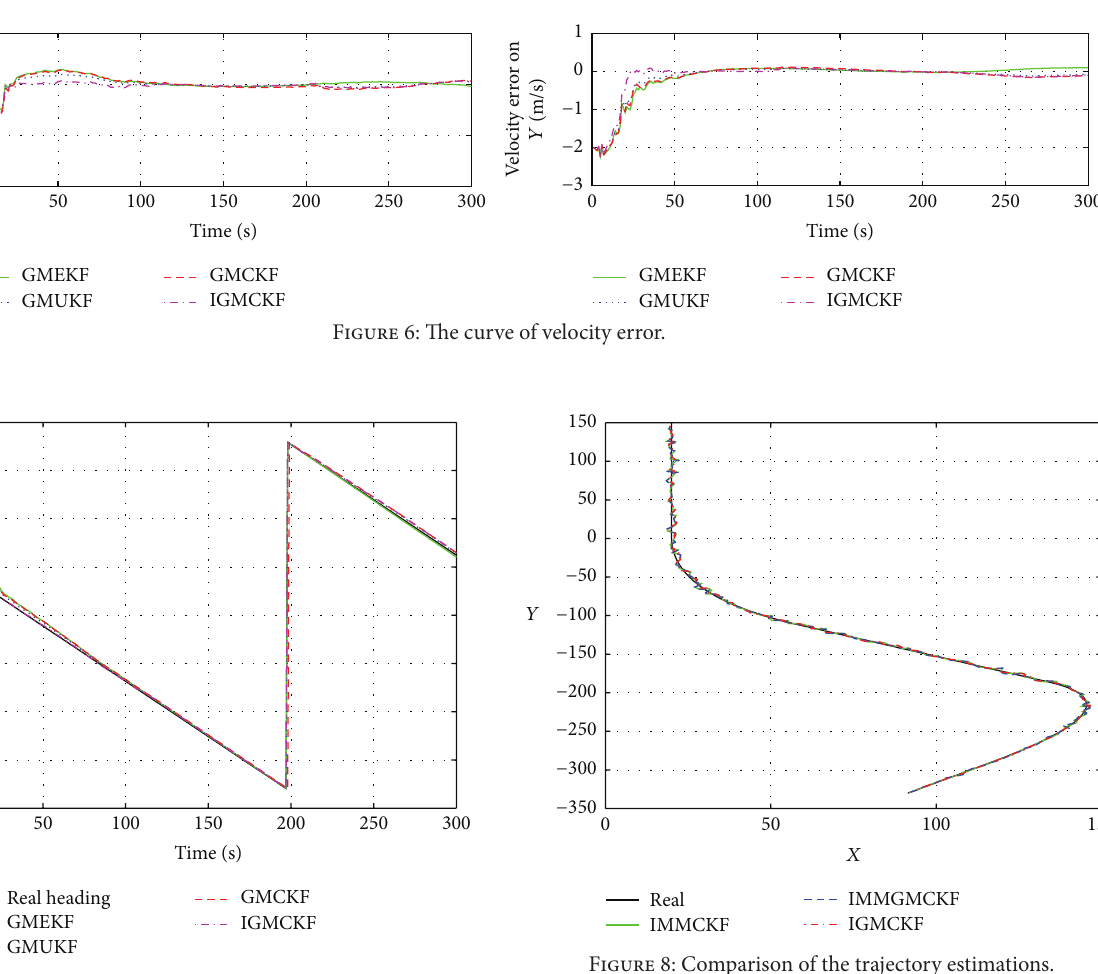
Figure 7: The estimation curve of target heading.